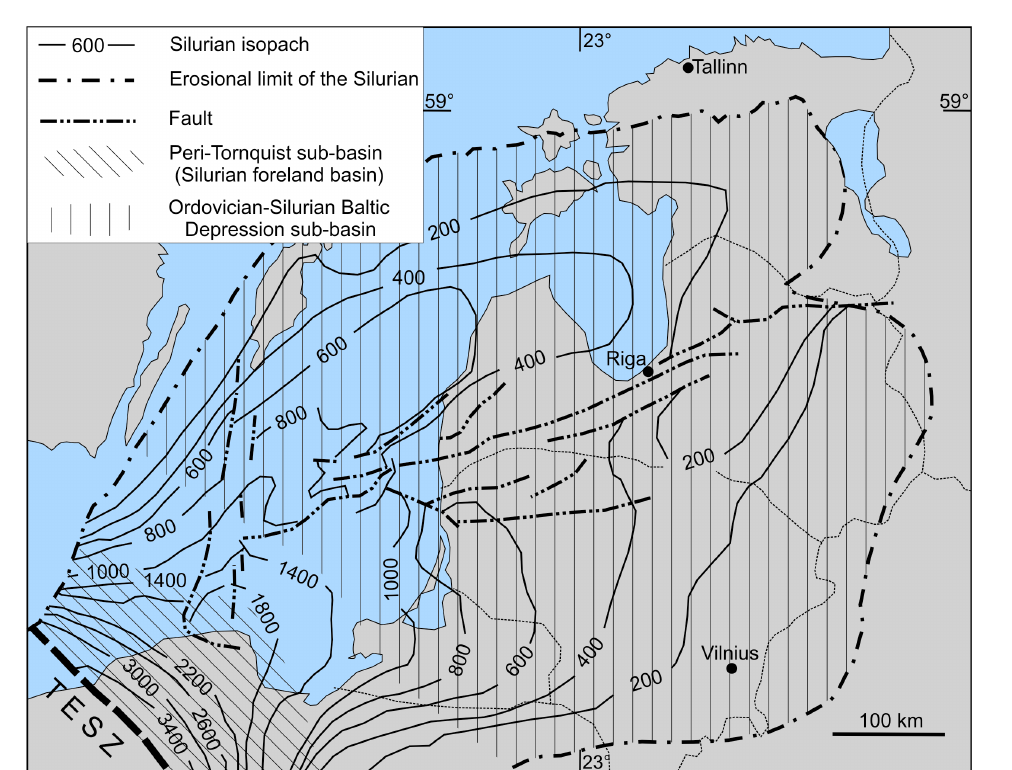
Fig. 14. Silurian isopach map of the Baltic Basin reflecting the formation/location of the narrow SE–NW-trending Silurian foreland basin along the Trans-European Suture Zone (TESZ) abutting the NW EEC margin (Peri-Tornquist sub-basin) and the cratonic interior Baltic Depression sub-basin that already started to evolve around the LeRPFZ in the Early Ordovician (modified after Lazauskiene et al.